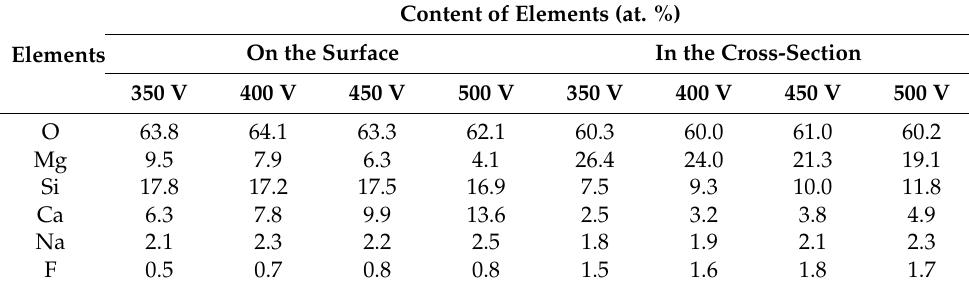
Table 1. The elemental composition of the W-coatings on Mg0.8Ca is determined by the EDX method.